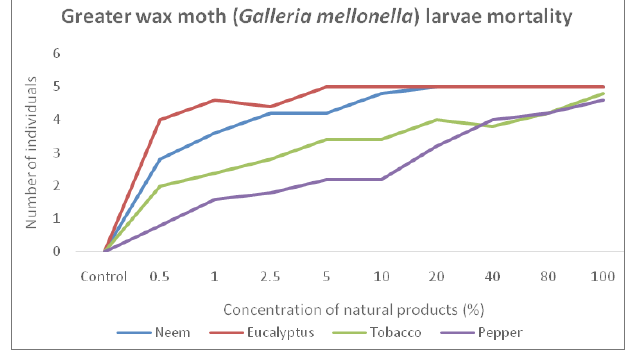
Fig 1. Greater wax moth ( Galleria mellonella ) mortality by different natural products atvariousconcentrations (%).